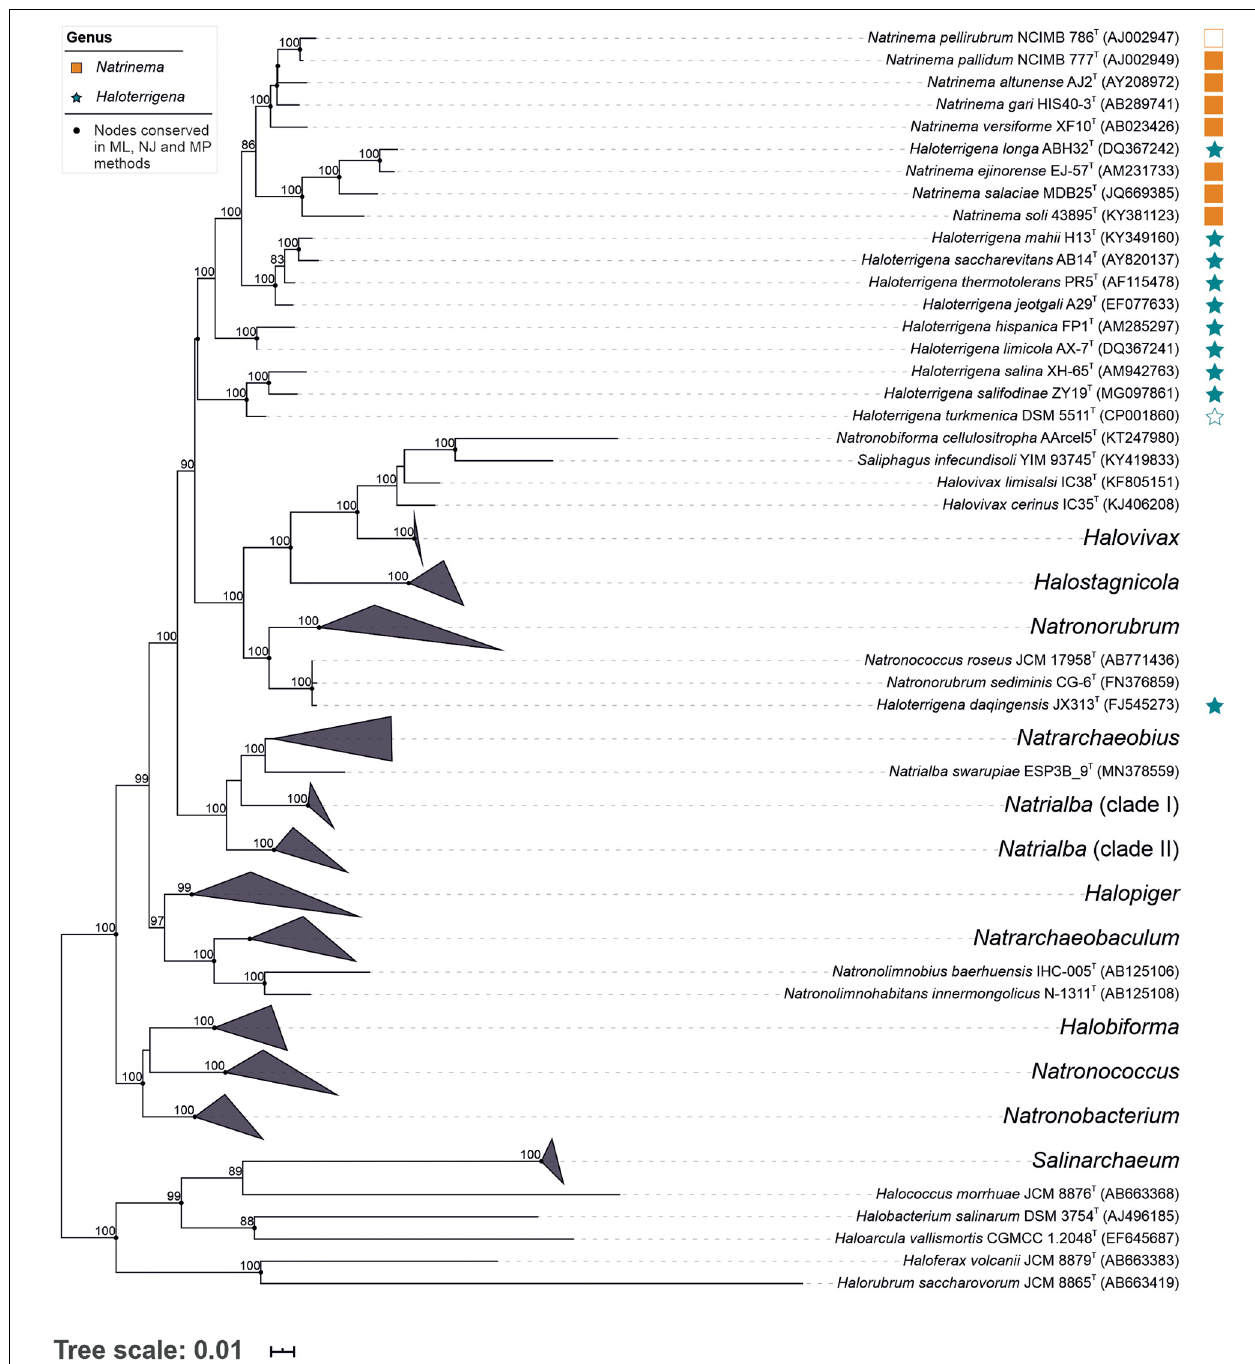
FIGURE 1 | Maximum-likelihood phylogenetic tree based on the 16S rRNA gene sequence comparison of members of the genera Natrinema and Haloterrigena and representatives of the most closely related genera of the family Natrialbaceae . Bootstrap values ≥ 70% (based on 1,000 pseudo -replicates) are shown above the branches. Bar, 0.01 changes per nucleotide position. Empty square and star indicate the type species of the corresponding